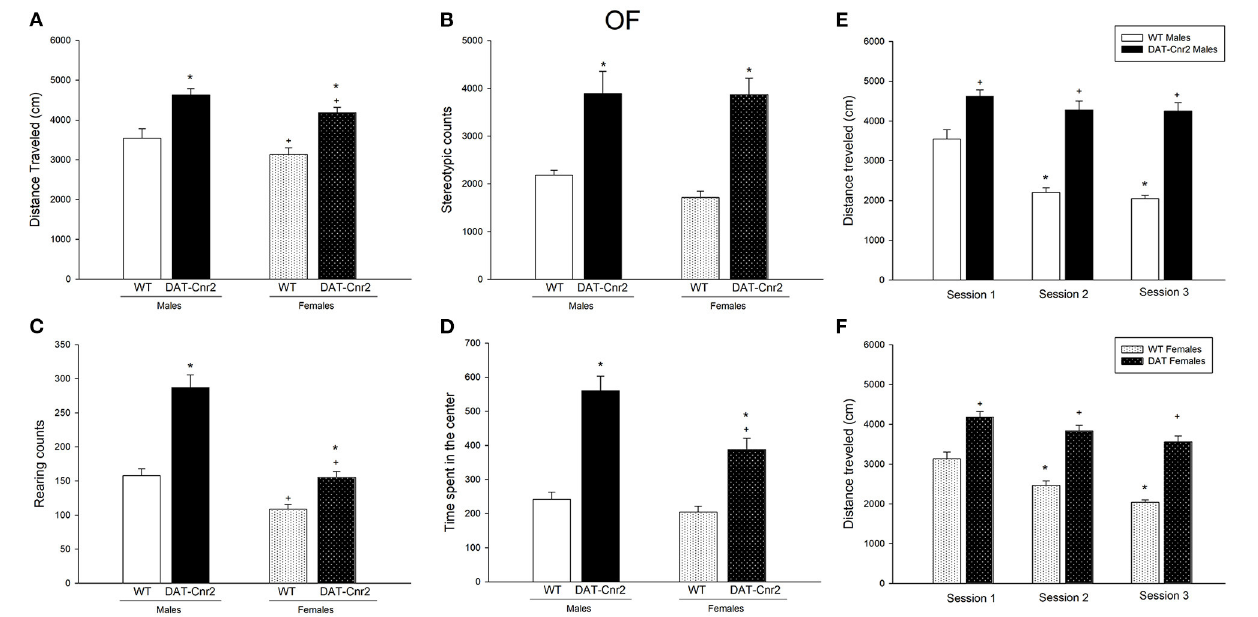
FIGURE 2 | Performance in the Open Field (OF) test in adolescent male and female DAT- Cnr2 cKO mice. Distance traveled (A) , stereotypic counts (B) , rearing counts (C) , and time spent in the center of the arena (D) . Distance traveled during 30min in the open field in basal conditions for 3 consecutive days, (E) for males and (F) for females. The white bars represent the WT and the black bars represent DAT- Cnr2 cKO mice. Data are expressed as mean ± SEM ( n = 10 mice per group). Two-way ANOVA followed by Tukey * p < 0.05 for genotypes; + p < 0.05 for sex and Two way RM ANOVA followed by Tukey for (E,F)